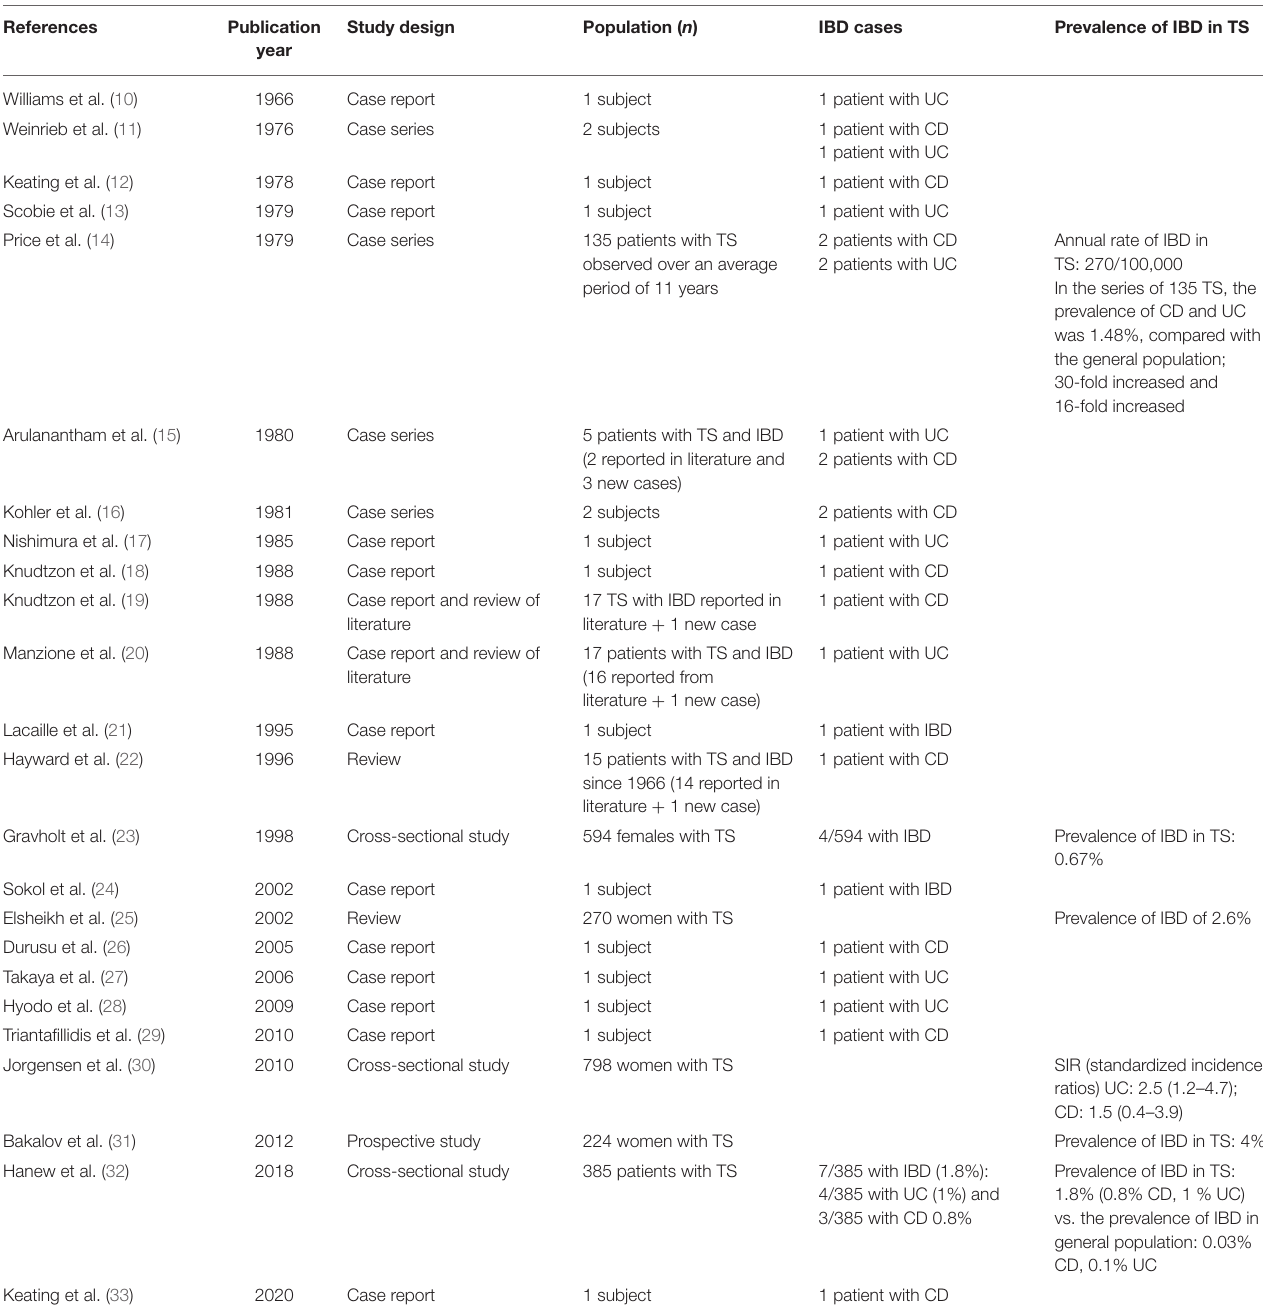
TABLE 1 | Characteristics of published studies reporting cases of IBD in TS